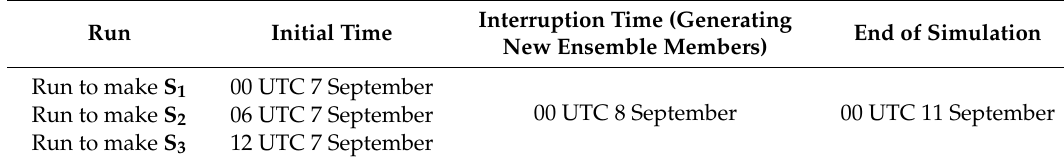
Table 4. Initial and interruption times of the WRF